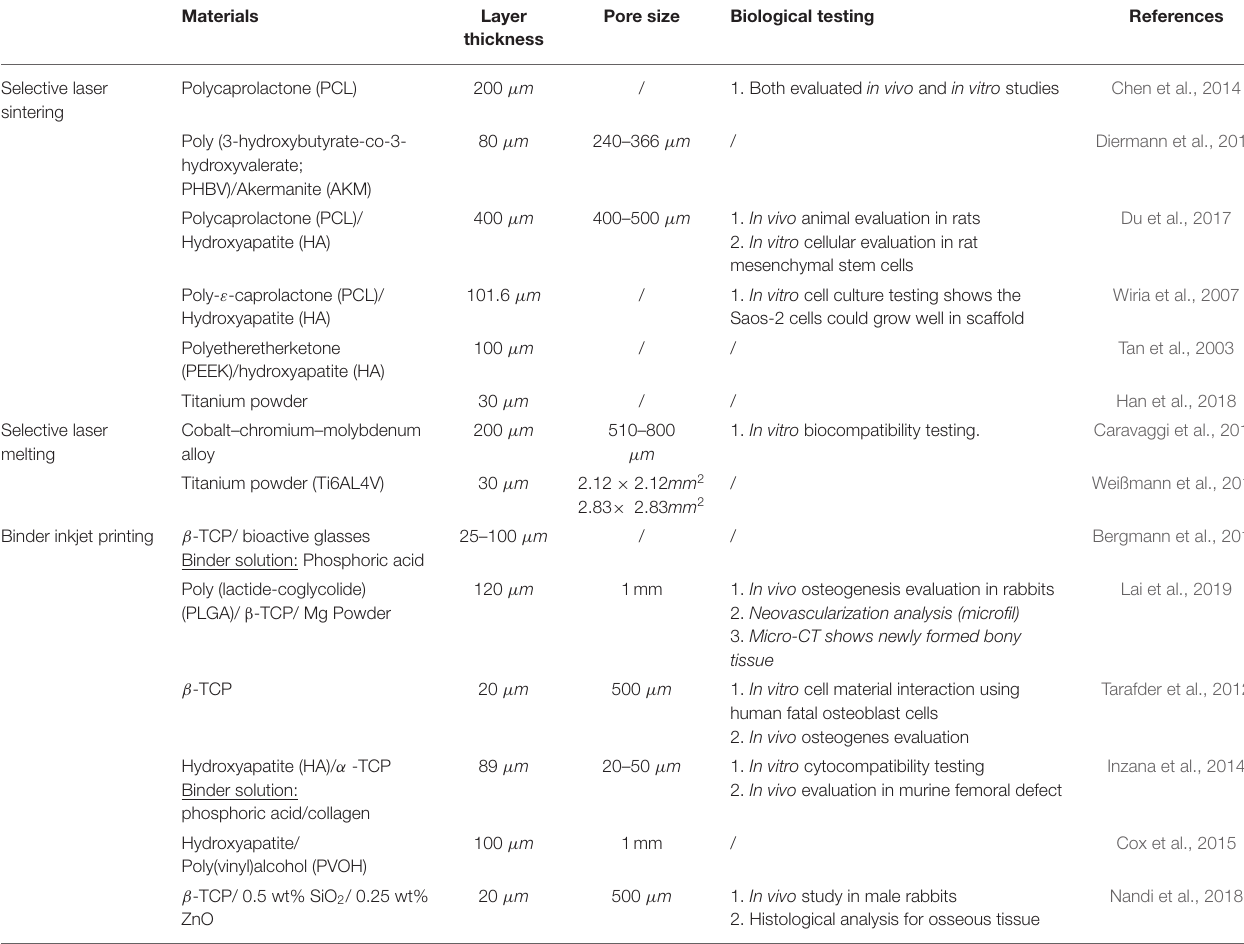
TABLE 1 | List of state-of-art 3D printed porous scaffolds for bone tissue regeneration.